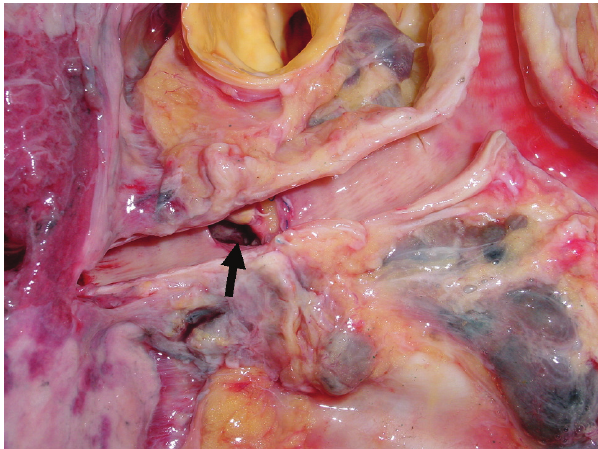
Figure 2 - Posterior view of the fistula orifice in the donor bronchus right below the anastomotic site